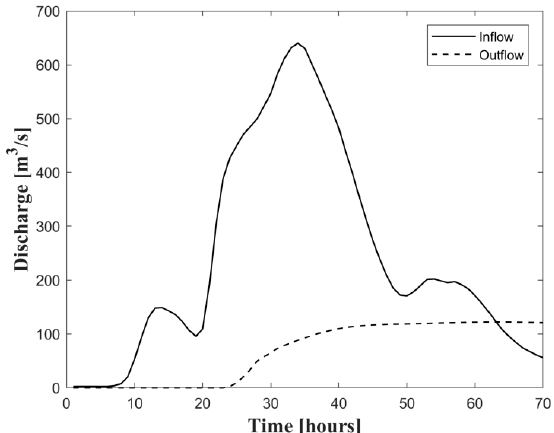
Figure 3. Inflow and outflow from the dam during the event occurred in 2013.